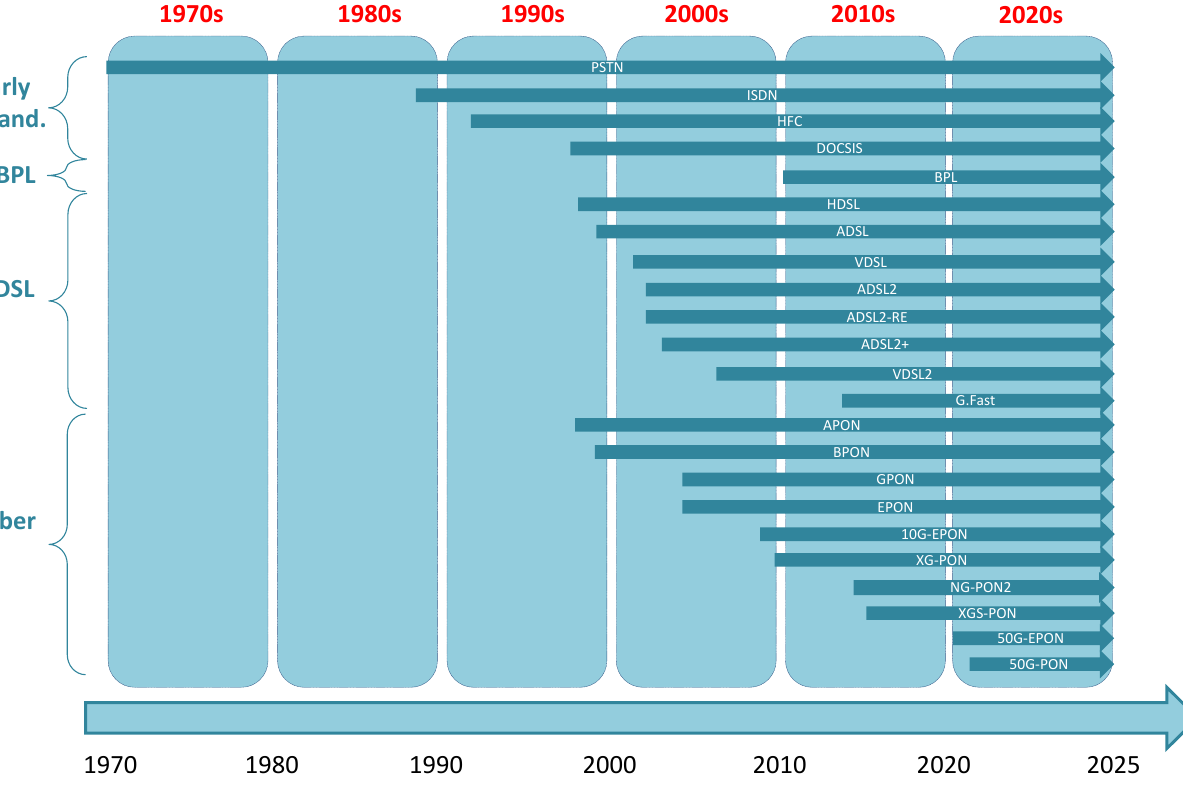
Figure 4. Most important deployed access standards over the past 50 years. Table 3. Details of various copper-based access standards.